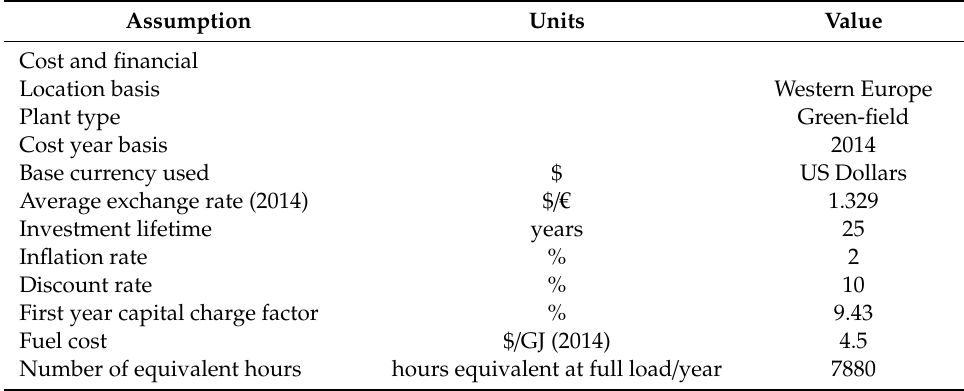
Table 7. Financial